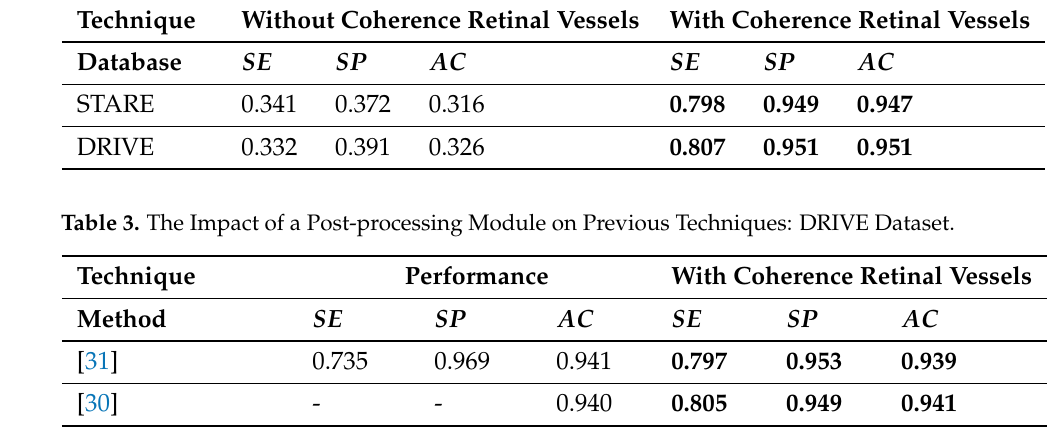
Table 2. The Post-processing Module’s Impact.